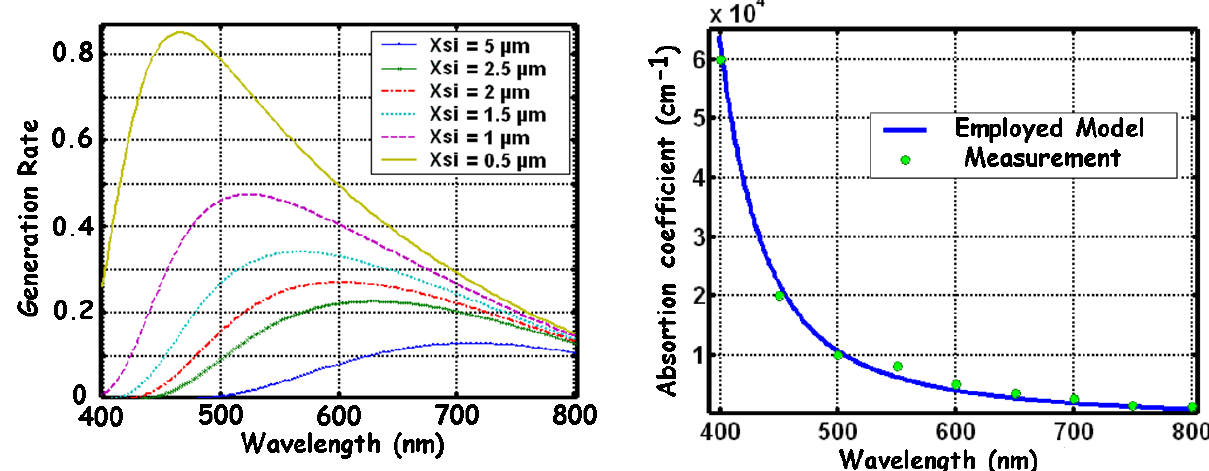
Figure 5. Simulation of the normalized generation rate of the electron-hole pairs versus wavelength, for several layers of intrinsic Si.